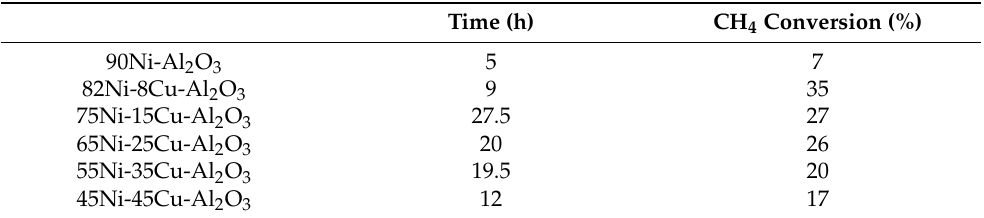
Table 9. The catalytic performance of Ni-Cu-Al 2 O 3 catalysts prepared using the coprecipitation method and tested at 675 ◦ C and 1 atm [87].